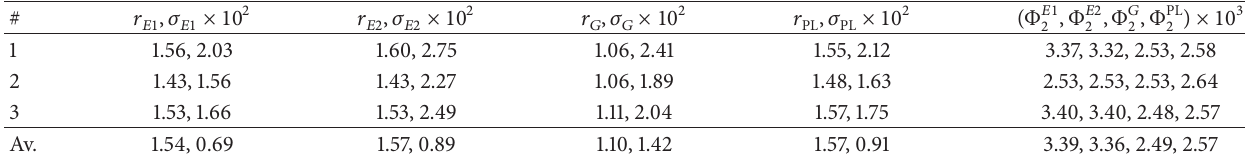
Table 6: Results for three rough surfaces generated using the 2D Ising model (the first three rows) and for the correlation function averaged over ten runs (the last row). The Monte Carlo simulations have been done at 𝑇 = 1.2𝑇 𝑐 with 10 6 Metropolis cycles. The surface size is 101×101 . The Table is arranged similarly to Table 2. The table contains the best fitting values of 𝑟 𝐸,𝐺, The results for the exponential fits Φ 𝐸1,2 2 for 𝜁(| x |) and 𝜁( x ) should be the closest to the true physical